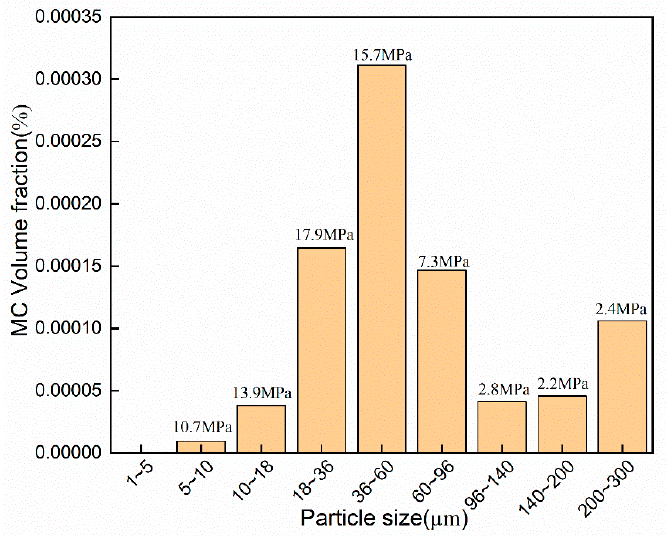
Figure 5. The volume percentage of precipitated phase at di ff erent scales and its corresponding strength increment in the test steel.